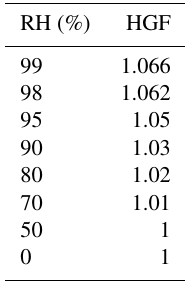
Table 2. Density and the refractive index of each aerosol type. Aerosol Density Real part of the refractive index Imaginary part of the refractive index (kgm − 3 ) at 550nm (at RH = 0%) at 550nm (at RH = 0%) Ammonium sulfate 1.77 × 10 + 3 1.53 10 − 7 Ammonium nitrate 1.7 × 10 + 3 1.56 10 − 9 Dust 2.56 × 10 + 3 1.56 6 × 10 − 3 Black carbon 1.8 × 10 + 3 1.75 0.44 Sea salt 2.17 × 10 + 3 1.49 0.006 Water 1.0 × 10 + 3 1.33 1.00023 × 10 − 8 Organics 1.4 × 10 + 3 1.53 1.96 × 10 − 9